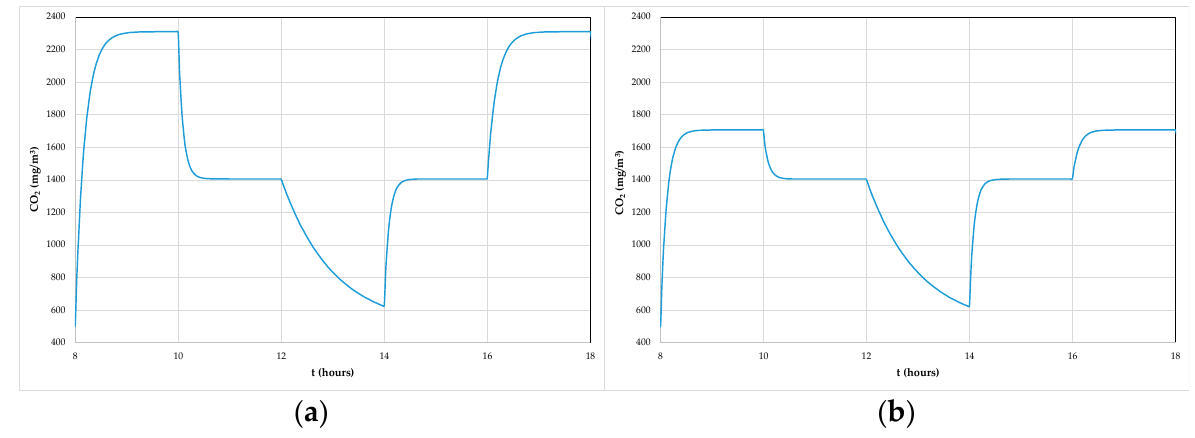
Figure 11. Evaluation of carbon dioxide (CO 2 ) concentration, for Case I ( a ) and Case J ( b ).